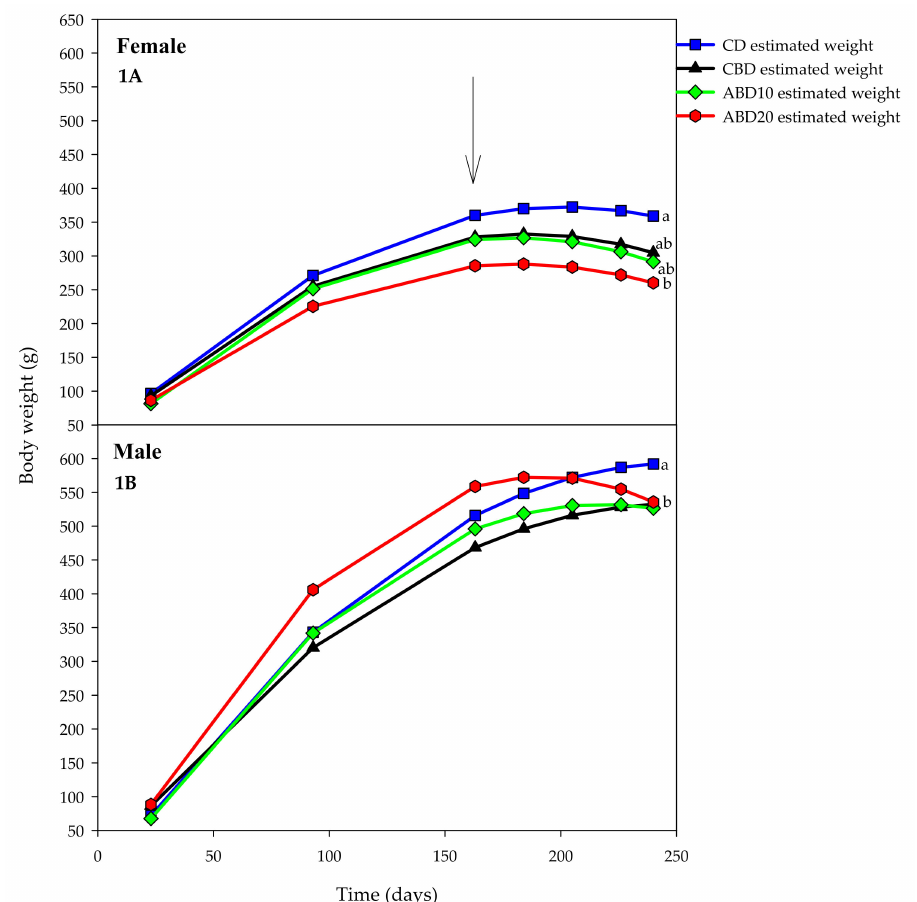
Figure 1. Body weights (mean) of control diet (CD(E), square, blue), control bread diet (CBD(E), triangle, black), diet bread with 100 g · kg − 1 amaranth (ABD10(E), diamond, green) and diet bread with 200 g · kg − 1 amaranth (ABD20(E), circle, red) rats during 240 days of the protocol. ( 1A ): female rats; ( 1B ): male rats. E: elevated blood lipids and glucose levels. The arrow indicates the start of experimental diets consumption. Body weights at the end of the trial showing di ff erent letters are significantly di ff erent ( p <